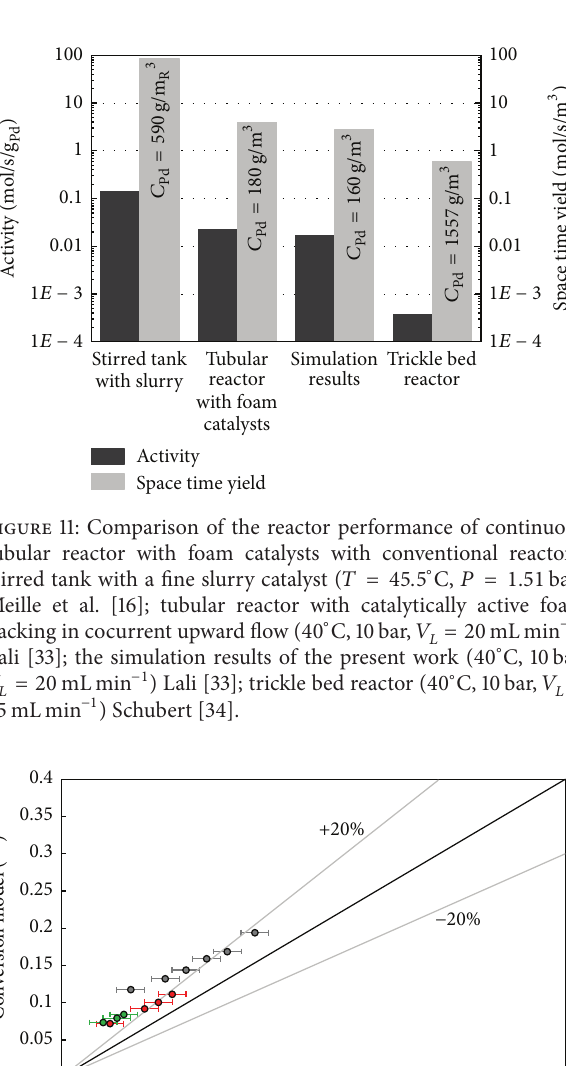
Figure 12: Parity chart of the model and experimental